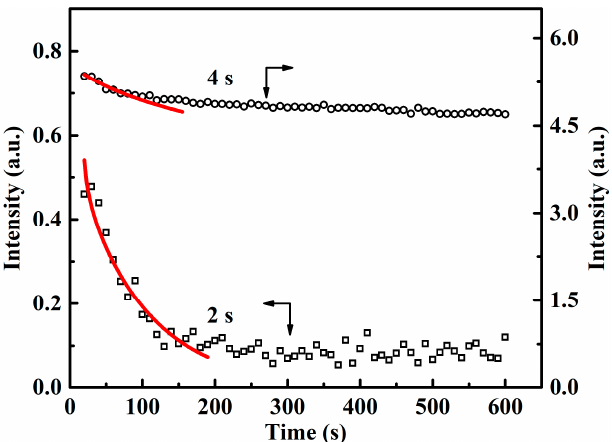
Figure 4. Time evolution of the equatorial streak integral intensity for flow time t s of 2 and 4 s. The open symbols are experimental data and the red solid lines are the fitting results with the modified Doi–Edwards memory function.